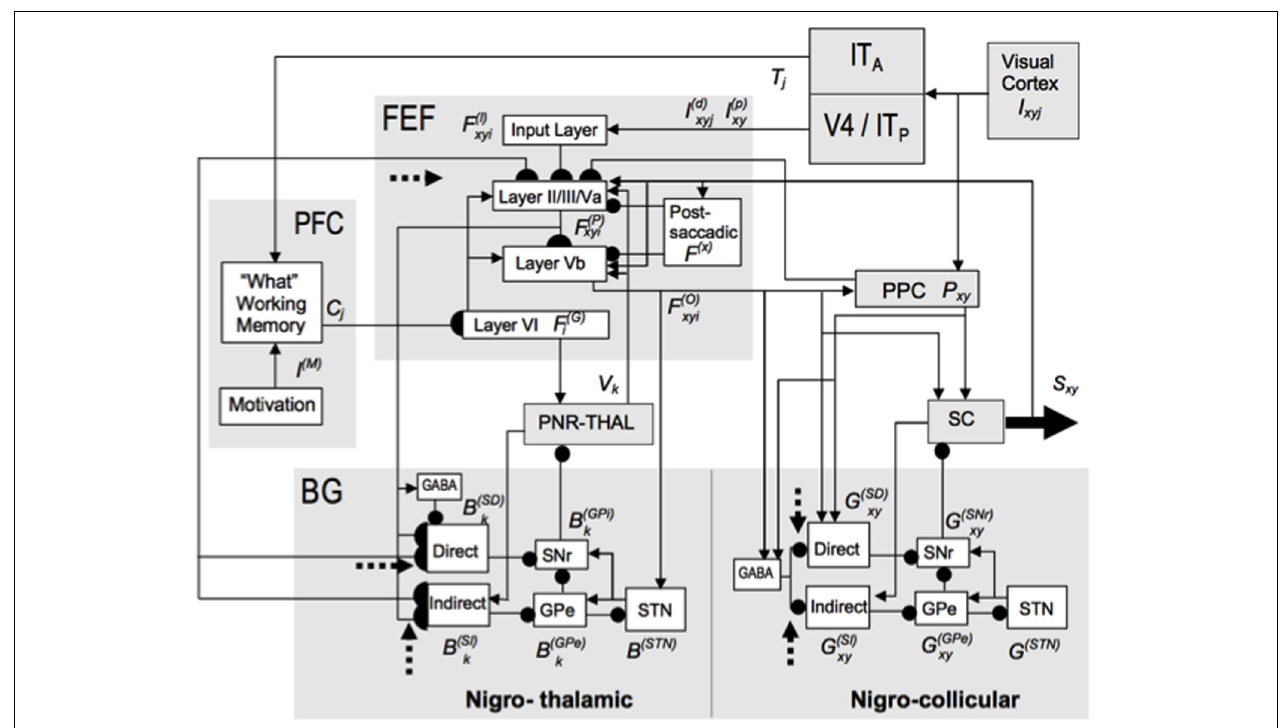
FIGURE 6 | The TELOS (TElencephalic Laminar Objective Selector) neural model of how basal ganglia (SNr) interactions gate learning of saccadic eye movement strategies. Due to the fact that parallel basal ganglia circuits regulate all aspects of cognition and behavior, similar basal ganglia dynamics may be expected in the explanations of many types of cognition and behavior. Separate gray-shaded blocks highlight the major anatomical regions whose roles in planned and reactive saccade generation are treated in the model. Excitatory links are shown as arrowheads, inhibitory as ballheads. Filled semi-circles terminate cortico-striatal and corticocortical pathways modeled as subject to learning, which is modulated by reinforcement-related dopaminergic signals (dashed arrows). See the archival article for details. [Reprinted with permission from Brown et al.